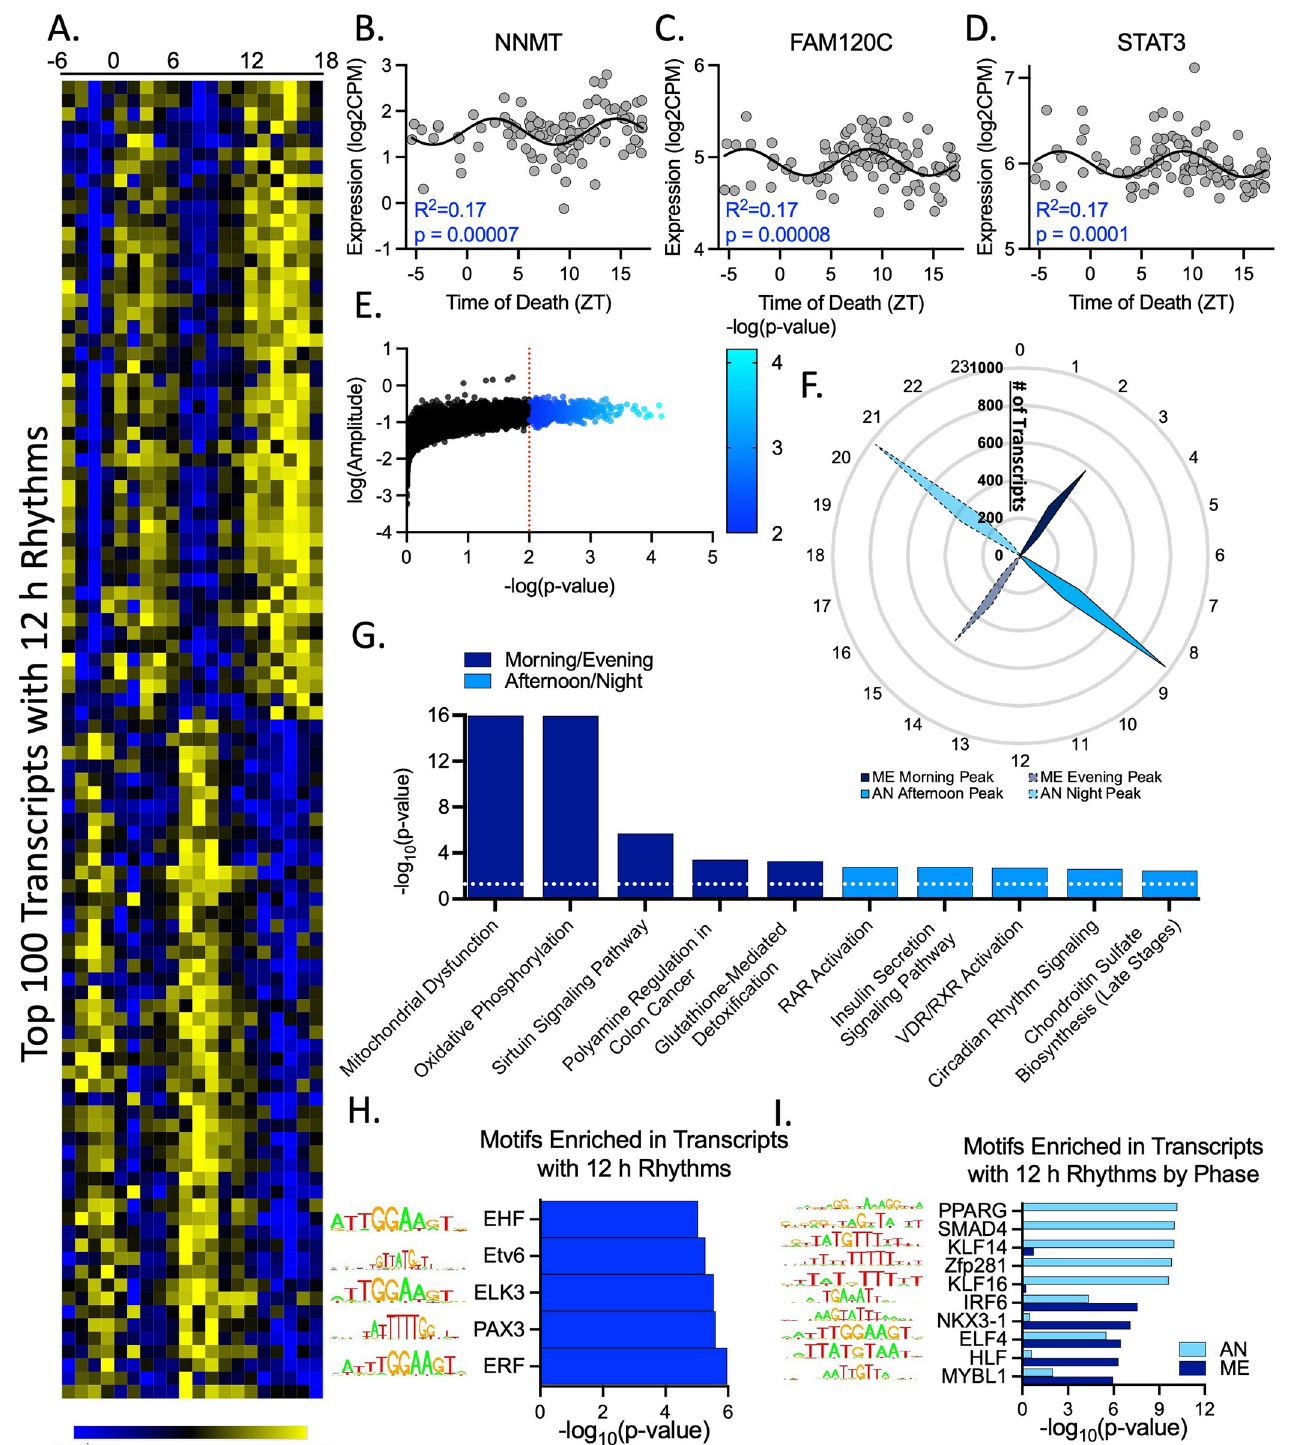
Fig 1. 12 h rhythms in the human DLPFC. ( A - E ) 12 h rhythms identified by a sinusoidal NLR. ( A ) Heatmap of top 100 transcripts with 12 h rhythms, ordered by phase. ( B - D )Gene expression over TOD scatterplots for the top 3 transcripts with 12 h rhythms showing the sinusoidal curve, goodness of fit (R 2 ), and p - value. Expression values for these graphs can be found in S6 File. ( E ) Plot comparing NLR-derived amplitude and p -values for all transcripts. Transcripts with significant 12 h rhythms in expression are denoted in blue ( p < 0.01). ( F ) Radar plot showing peak expression times (ZT) of transcripts with 12 h rhythms ( p < 0.01). Outer scale in ZT (h), radial scale represents number of transcripts, solid lines indicate first peak, and dashed lines indicated second peak. ME peak